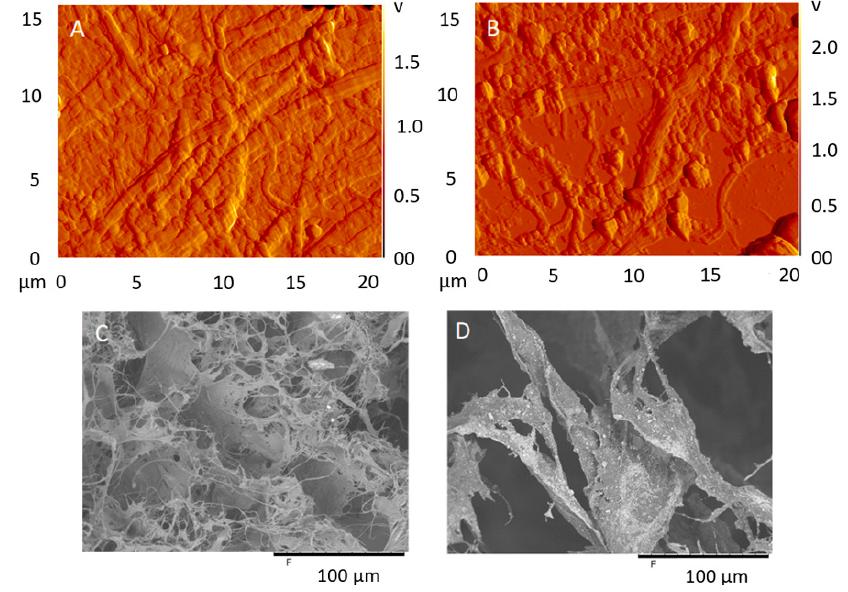
Figure 3. ( A ) AFM image of CNF, ( B ) AFM image of FiberLean TM , ( C ) SEM image of CNF, and ( D ) SEM image of FiberLean TM .